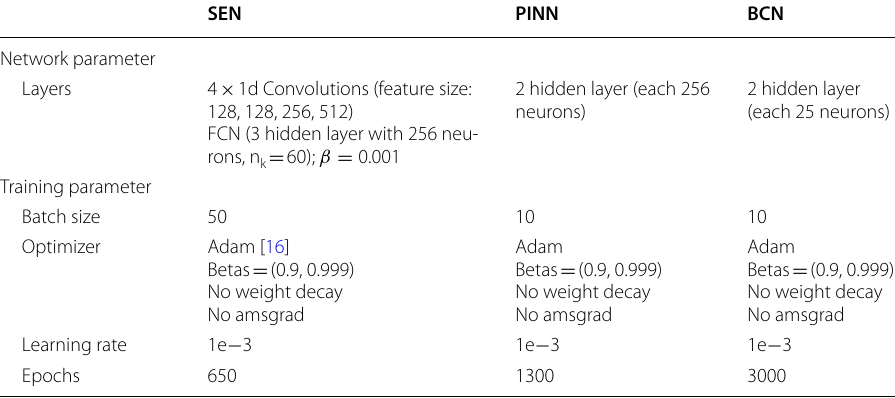
2 hidden layer (each 256 neurons)